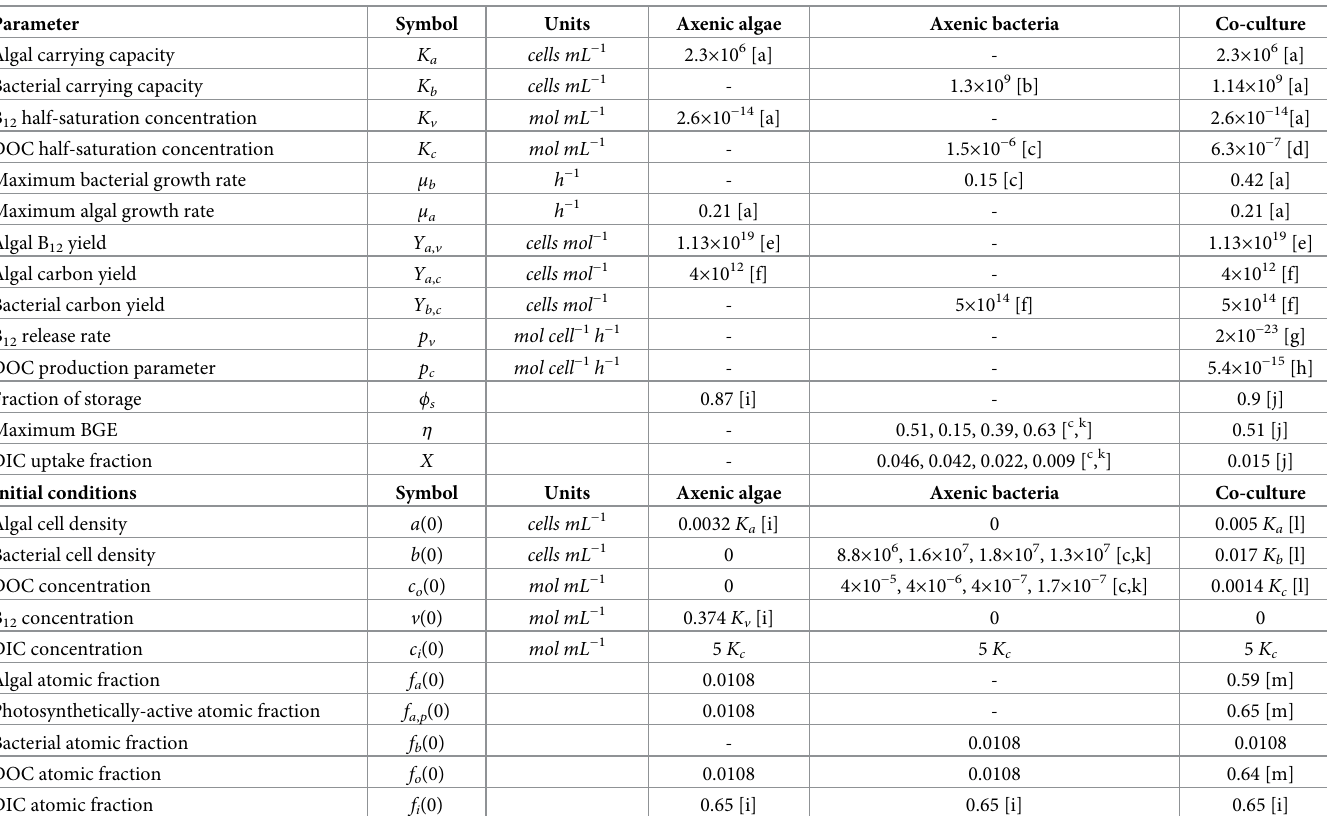
Table 1. Model parameters and initial